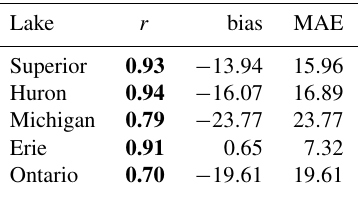
Table 5. Comparison of annual maximum ice cover of the Great Lakes from GLERL records and SMMR and SSM/I–SSMIS data. Bold numbers correspond to p < 0 .